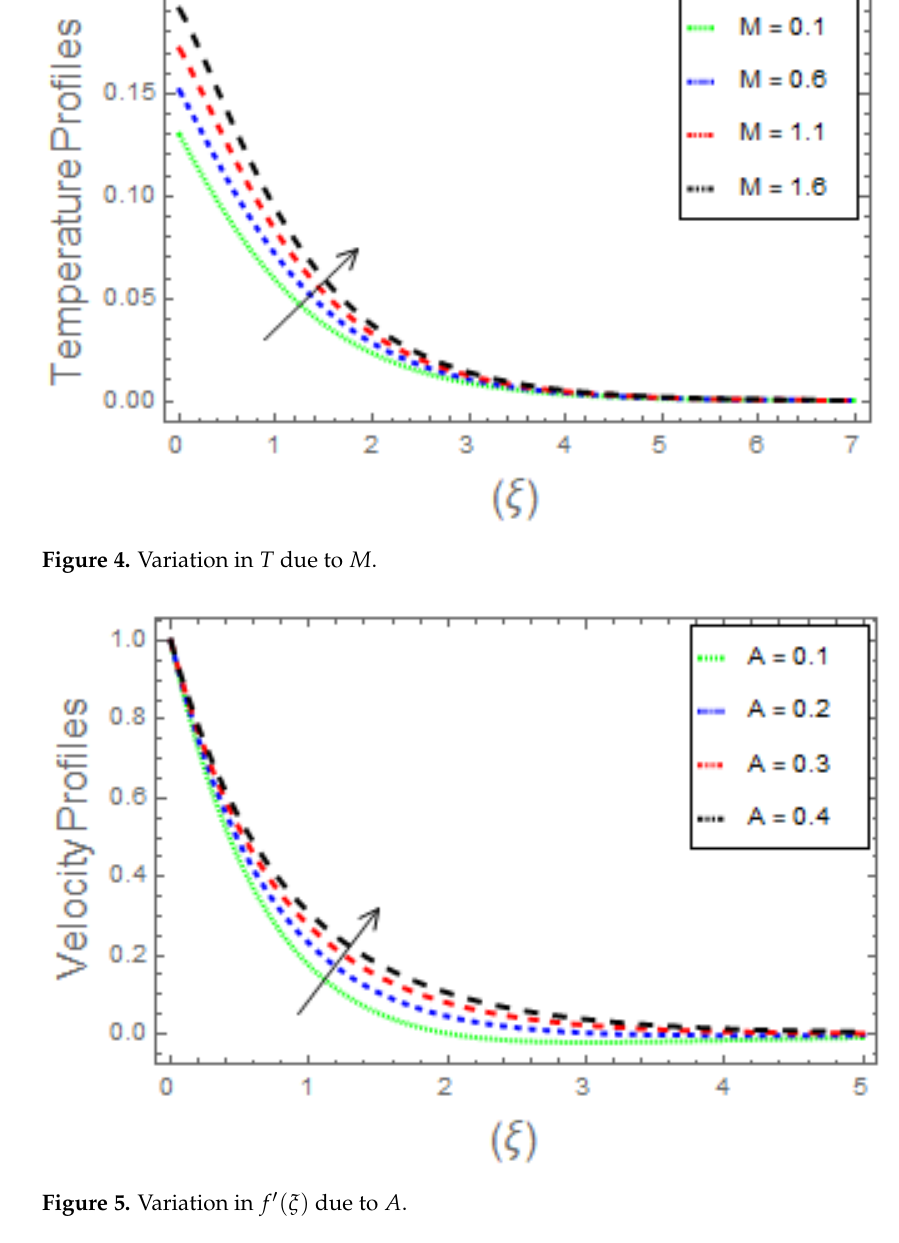
Figure 5. Variation in